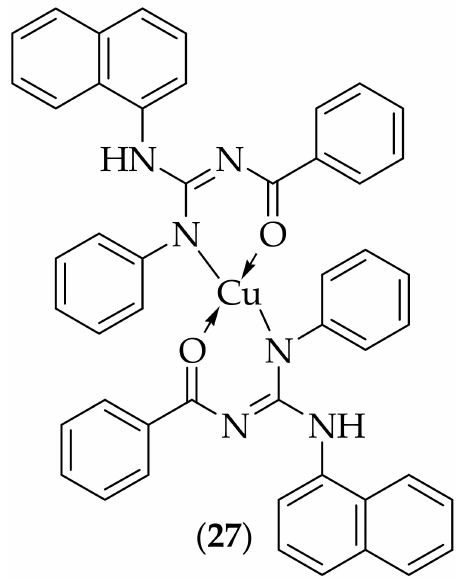
Figure 16. Copper (II) complex antifungal agent ( 27